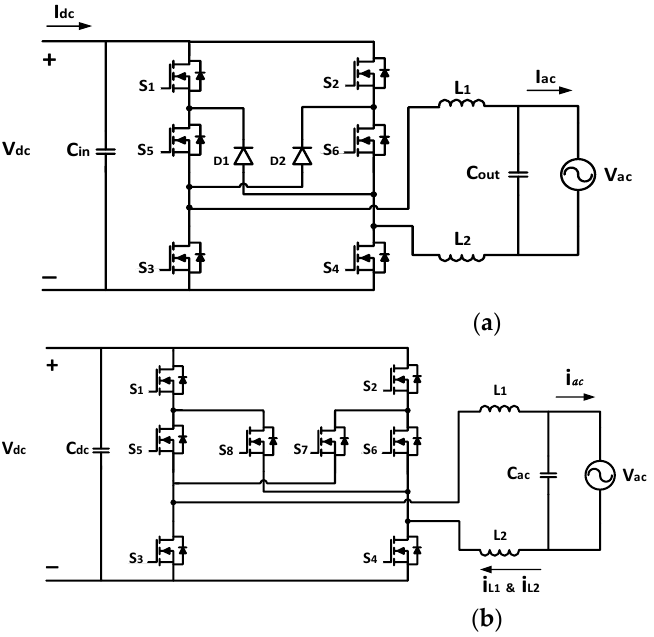
Figure 11. H6 bidirectional inverter topology: ( a ) standard H6 [53] and ( b ) synchronous H6 [54]. A small number of papers discuss bidirectional inverters for a bipolar DC configu- ration, in which the DC and low-frequency CM voltages need to be closely regulated to ensure symmetrical DC bus voltages and to reduce leakage current. The high-frequency CM noise can be filtered out by passive components, as with unipolar DC systems [23]. The authors of [76] proposed a control solution for grounded unidirectional inverter systems with power converters, which is based on an active common-mode duty cycle injection approach. As a result, a reduction in voltage ripple was achieved, which minimized the ground leakage current. However, this control technique does not apply to bidirectional operation. Therefore, the topology proposed in [57] and presented in Figure 12 was de- signed for enabling bidirectional capability and high frequency. Moreover, the leakage current was reduced due to the decoupling of the CM voltage, while the